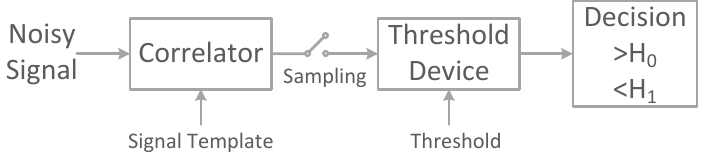
Figure 1. Block diagram of the matched filter